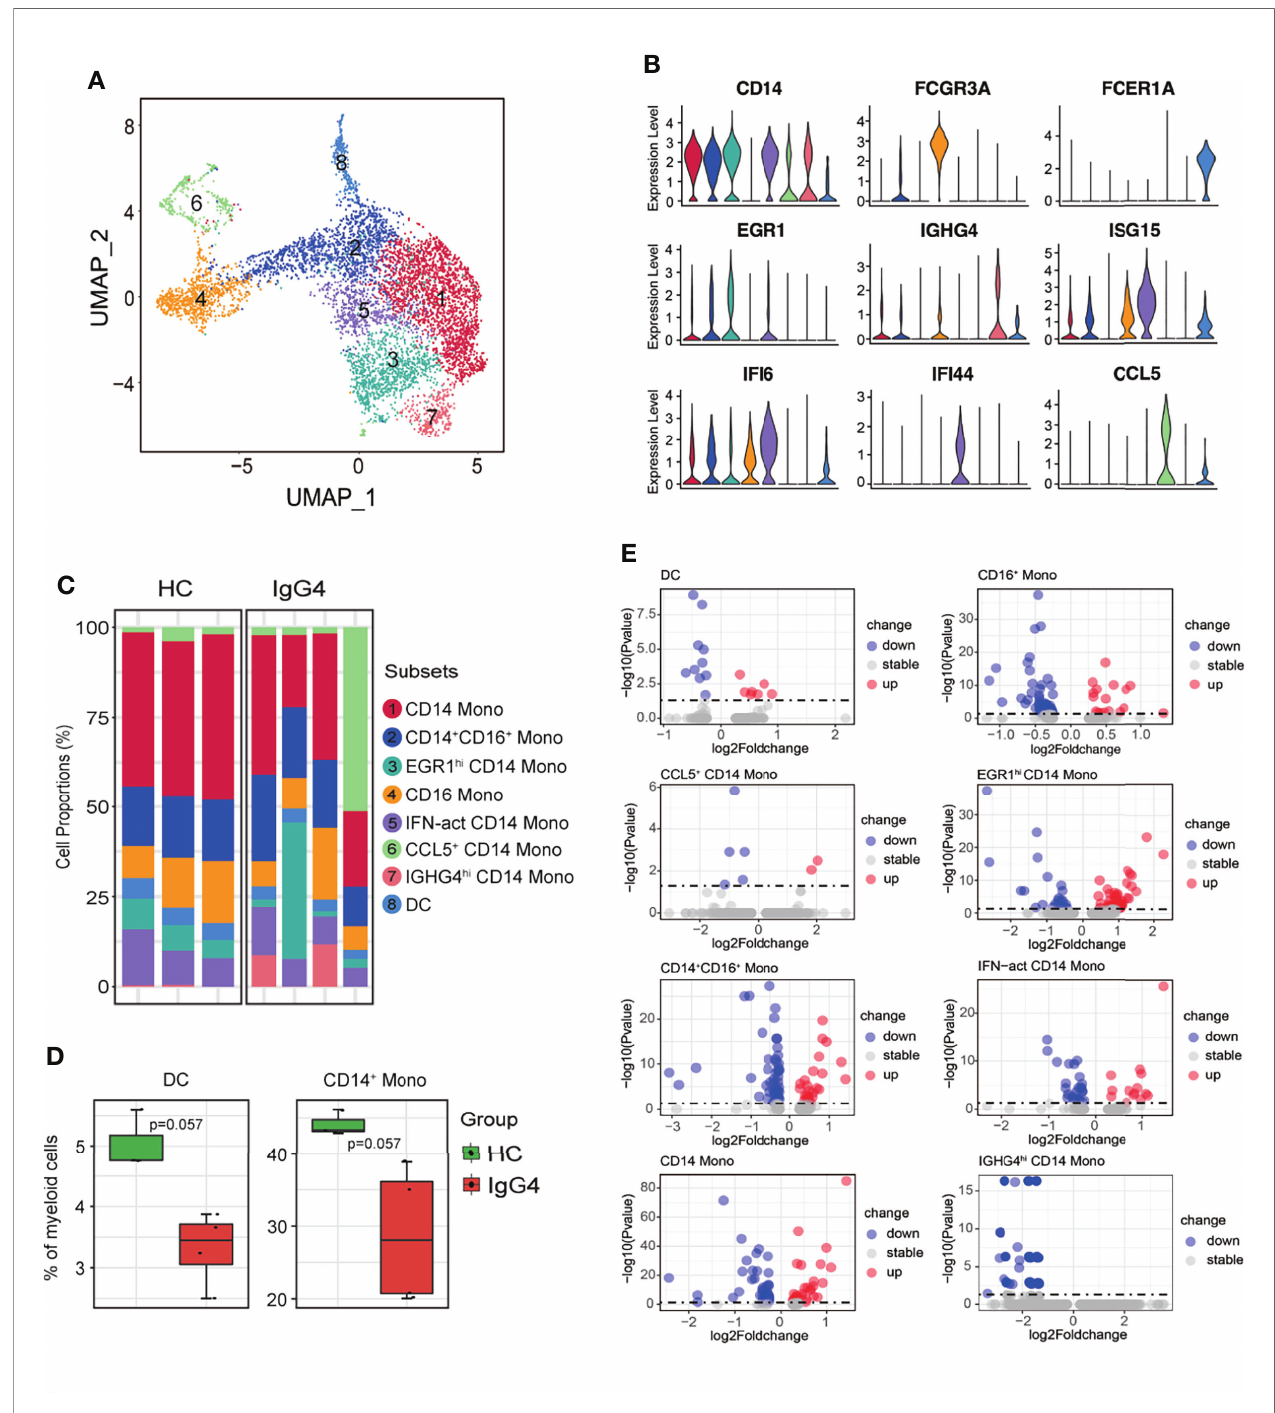
FIGURE 3 | The heterogeneity and transcriptional features of myeloid cells in IgG4-RD. (A) UMAP representation of 6324 myeloid cells, showing the formation of 8 clusters. (B) Violin plots showing expression distribution of canonical cell markers. (C) Bar plot showing cluster abundance of each myeloid cell type across all samples. (D) Percentages of DC and CD14 + Mono between HCs and IgG4-RD. The y -axis shows the average percentage. Error bars are shown in mean ± SEM. Student t -test was used for the analysis, and P < 0.05 is considered a signi fi cant difference. (E) Volcano plot showing the DEGs of myeloid cell subtypes between HCs and patients with IgG4-RD. Data are expressed as mean ±